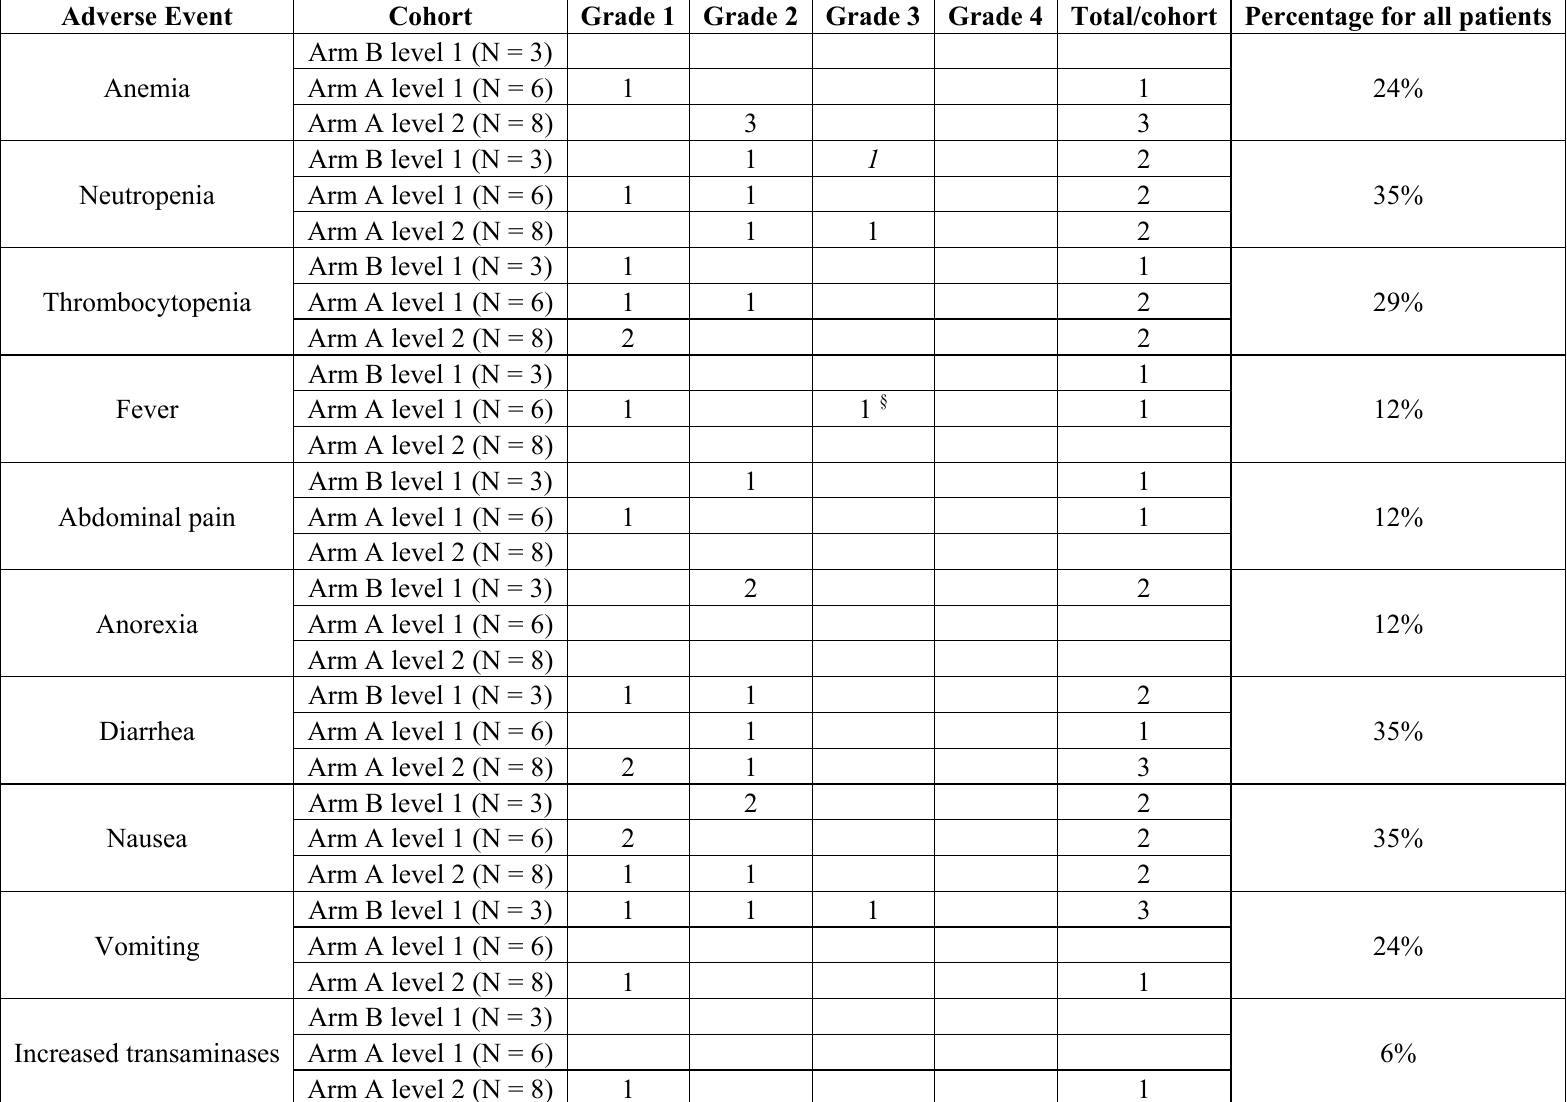
Table 2. Adverse events per cohort for all cycles of